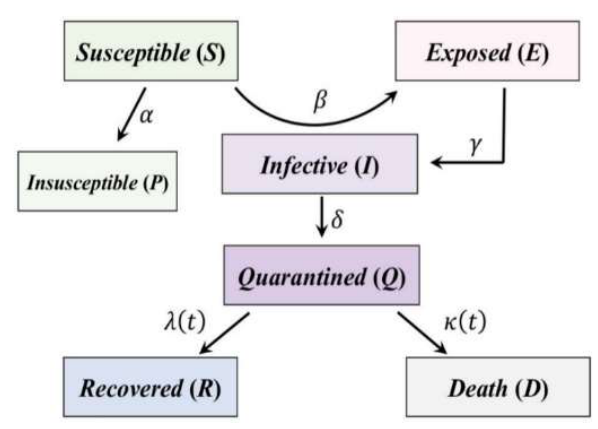
Figure 1. Generalized SEIR (Susceptible-Exposed-Infective-Recovered) model scheme (modified from [5]).